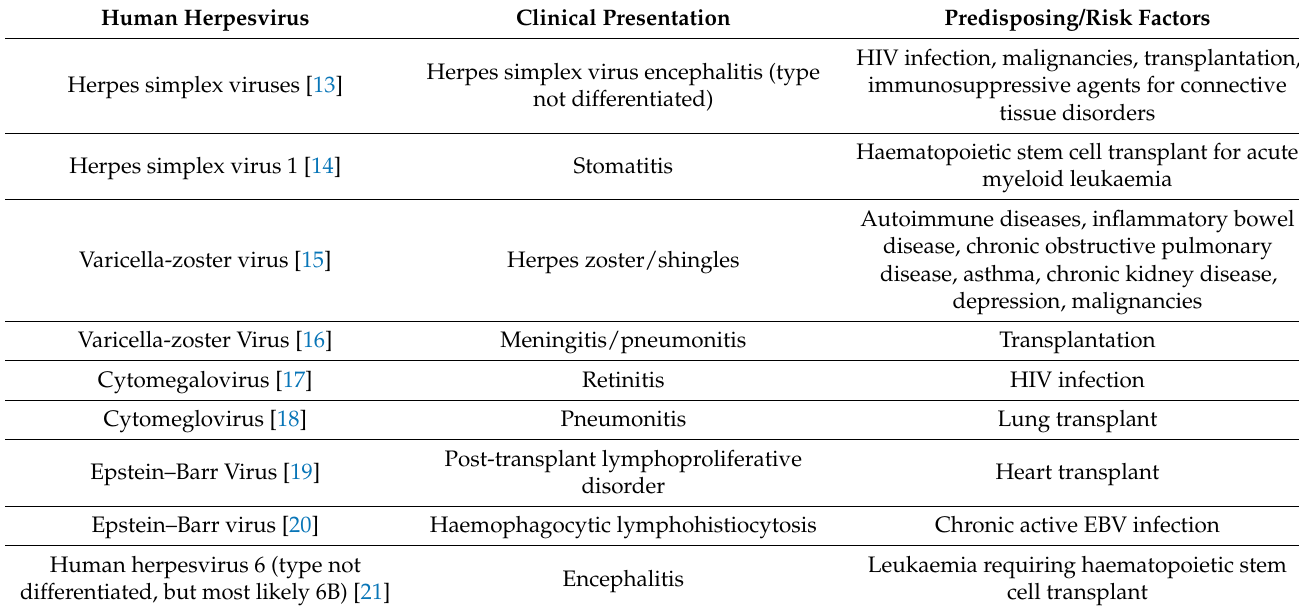
Table 1. Clinical presentations and risk factors for severe human herpesviruses infections in immuno- compromised/immunodeficient individuals (selected